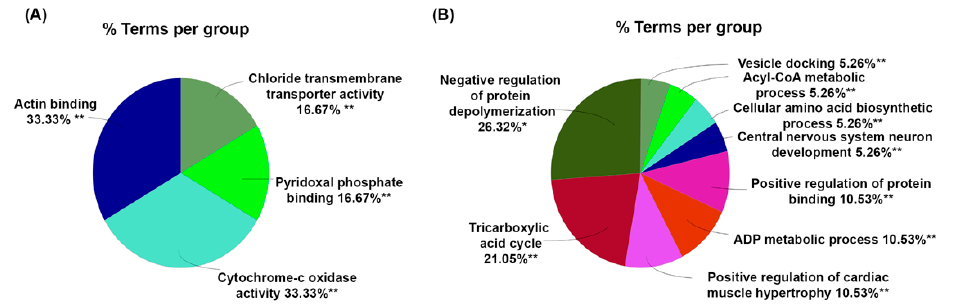
Figure 2. Mapping of molecular functions ( A ) and biological processes ( B ) using ClueGO. The asterisks represent the group term p-value representing each category. * p < 0.05 and ** p < 0.01.